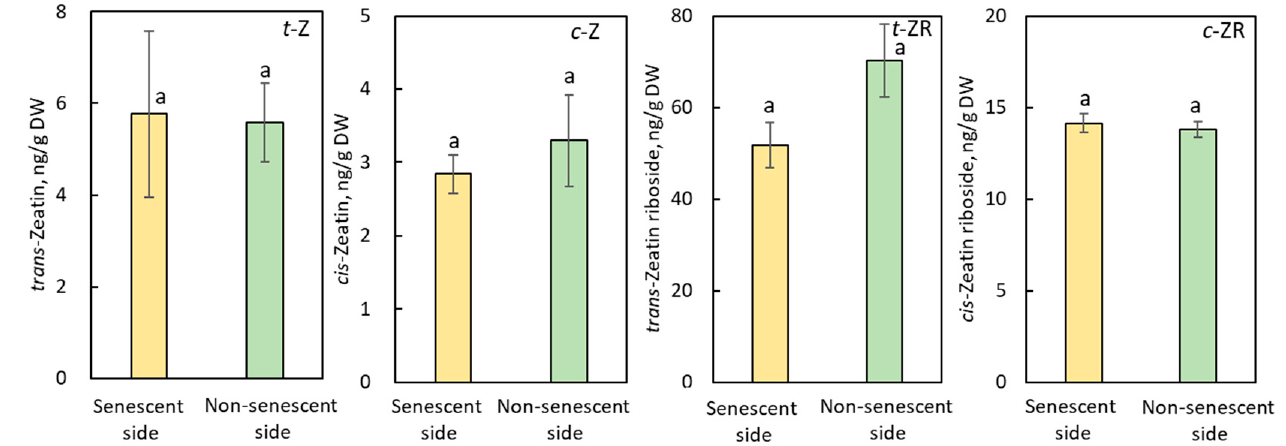
Figure 5. Endogenous levels of cytokinins in the senescent and non-senescent sides of the SAZ induced by JA-Me in the internode explants of Bryophylum calycinum . t-Z: trans -Zeatin; c-Z: cis -Zeatin; t-ZR: trans -Zeatin riboside; c-ZR: cis -Zeatin riboside. Values are the mean with standard error (n = 6). Different letters on the column (a) indicated statistically significant at p < 0.05 after ANOVA.